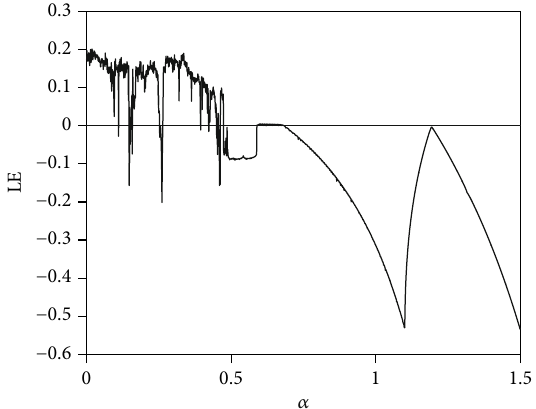
Figure 8: The maximum Lyapunov exponent with respect to α corresponding to Figure 7.